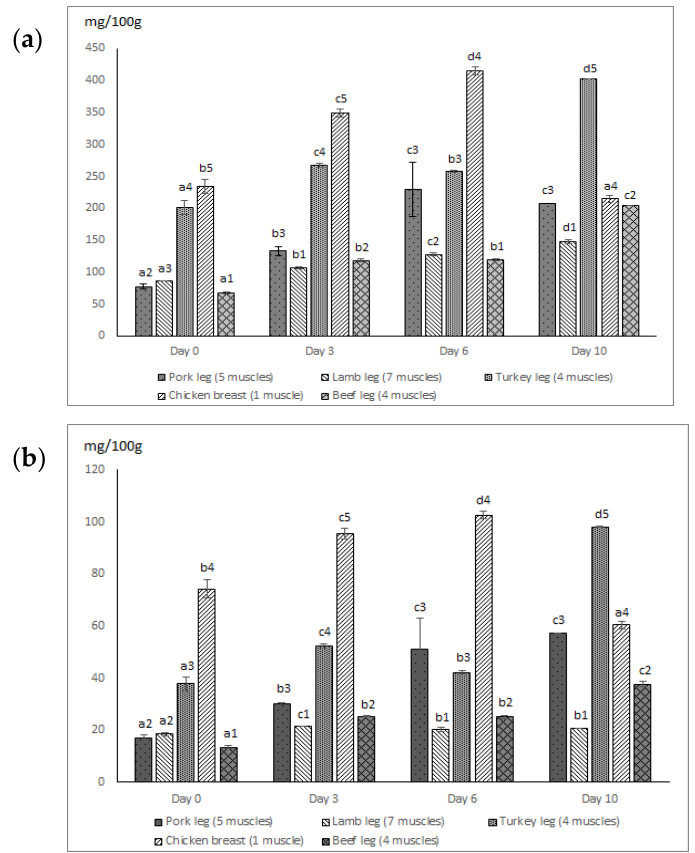
ND: Not Detected. Each value is the mean of three replicates per meat sample and storage day ± standard deviation (SD). For every type of free amino acid: Different superscript letters in the same row indicate significant difference ( p < 0.05) between storage days for the same meat type, and different superscript numbers in the same column indicate significant difference ( p < 0.05) between meat types for the same storage day.